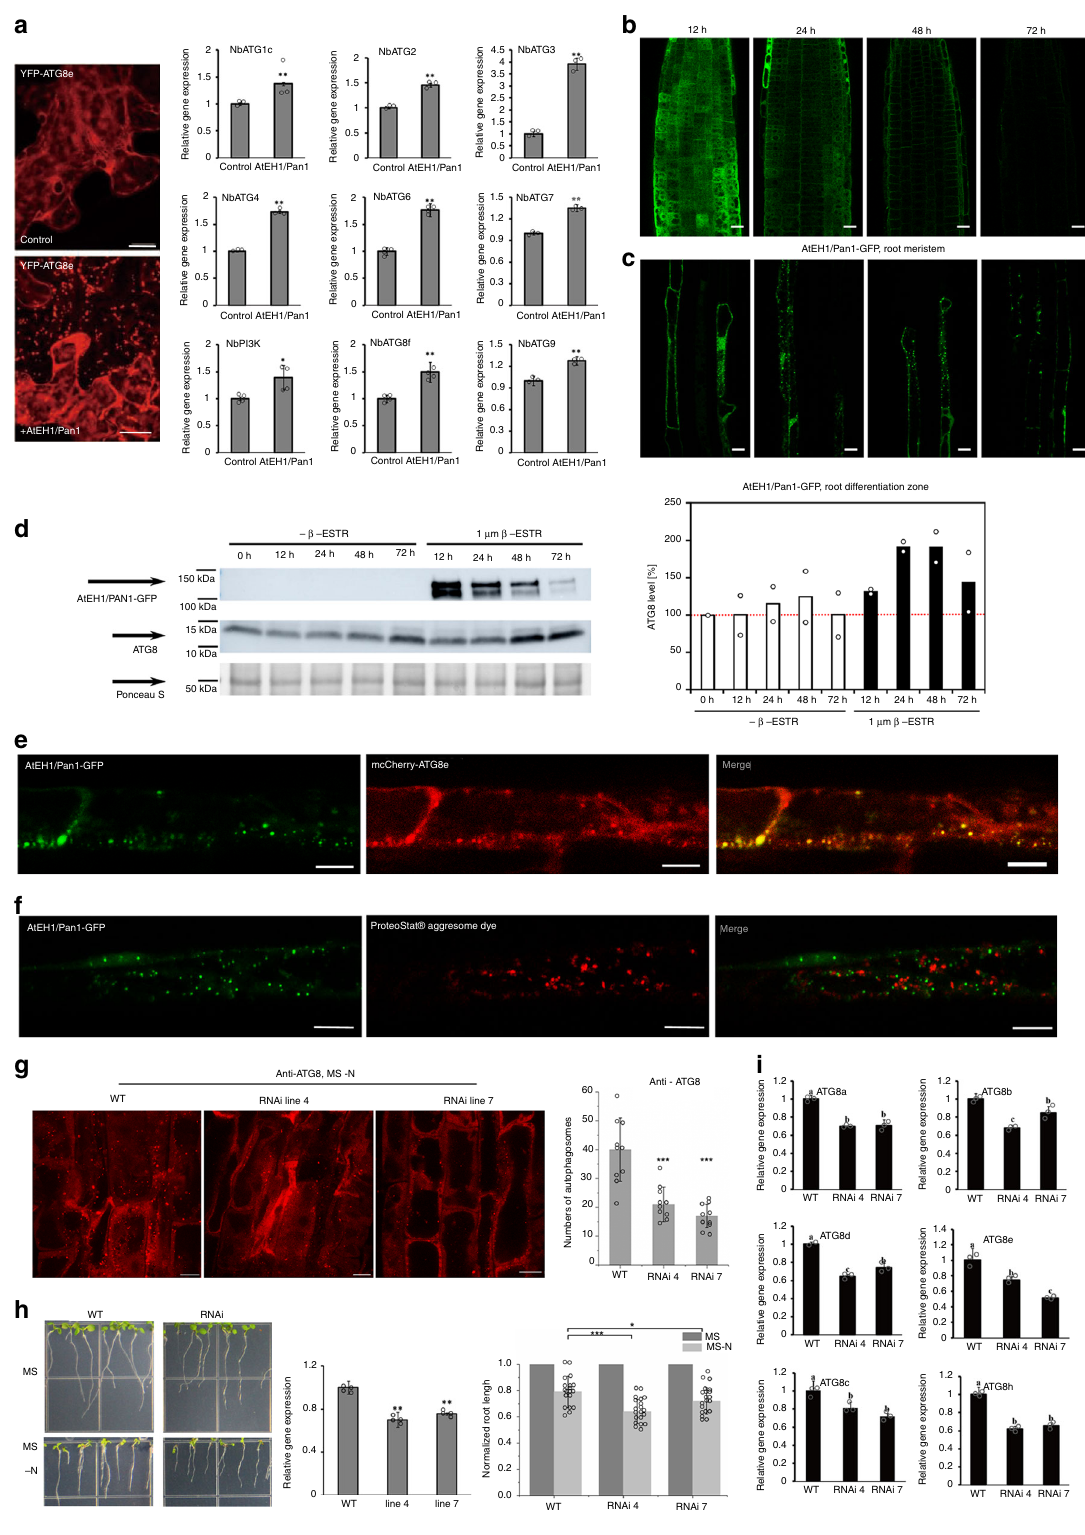
was used to quantify ATG8 levels (https://www.ncbi.nlm.nih.gov/pubmed/ 22930834). Generation of RNAi Arabidopsis plants . Arabidopsis (Col-0) was grown on either ½ MS agar (1% Sucrose, pH 5.6) or compost in long-day conditions (16h light, 22°C and 8h darkness, 18°C). Arabidopsis transformations were achieved by fl oral- dipping. The AtEH1/Pan1 RNAi construct was obtained from AGRIKOLA 64 as an